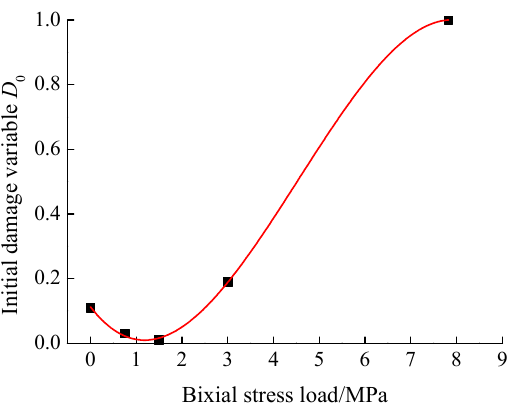
rock was considered to be 1 when the biaxial static load reached the biaxial compressive strength. ate.